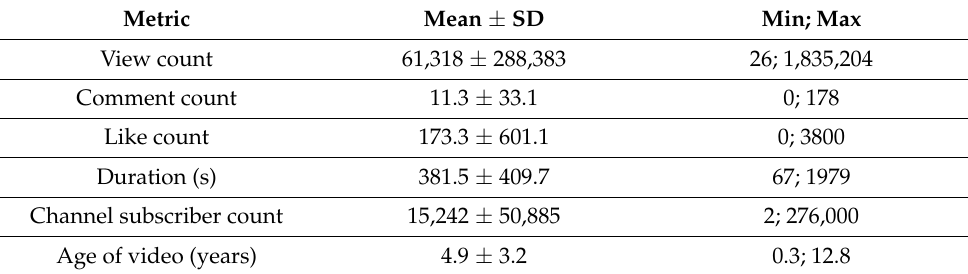
Table 4. Viewing metrics of the 40